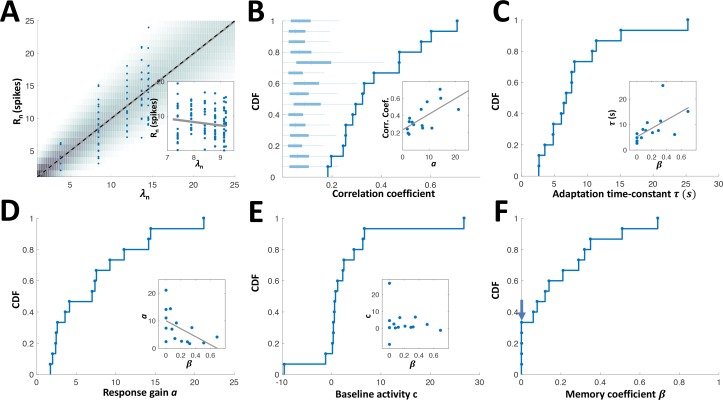
Empirical distributions of model parameters.(A) Circles: measured responses of one example adapting cell, plotted against the response rates of the model for this cell (computed from the interval sequence using equations (1) and (2) in Methods); background shading: spike count distribution of the model; solid grey line: linear regression (Pearson’s correlation: 0.706, p < 10−4 random permutations); dashed black line: identity diagonal. Inset: responses vs. rates for example non-adapting cell (Pearson’s correlation: -0.14, p = 0.123 random permutations). (B) Cumulative distribution function (CDF) of Pearson’s correlation coefficient between the measured responses and the response rate λof the fitted model. Correlations for all adapting cells were statistically significant (P < 0.05, random permutations); box-plots: distributions of correlations (absolute value), obtained by random permutations of responses of each cell. Inset: the correlation coefficient strongly depended on the response gain a; high gain neurons yielded the strongest correlations. Grey line: linear regression. (C) CDF of adaptation time-constant τ. Inset: cells with high values of βhad longer time-constants (Pearson’s correlation 0.594, p = 0.019). (D) CDF of response gain parameter a. Inset: cells with low values of β had higher gain (Pearson’s correlation -0.532, p = 0.04), that is the history-independent cells provide more precise temporal representation (see Figure 6F). (E) CDF of baseline activity parameter c. Negative values were obtained for units with high threshold, that is that stopped responding altogether at short time intervals. Inset: baseline activity was not significantly correlated with β (Pearson’s correlation -0.15, p=0.593). (F) CDF of memory parameter β. Note that 33% (5/15) of the cells were best fitted with β=0 (arrow).